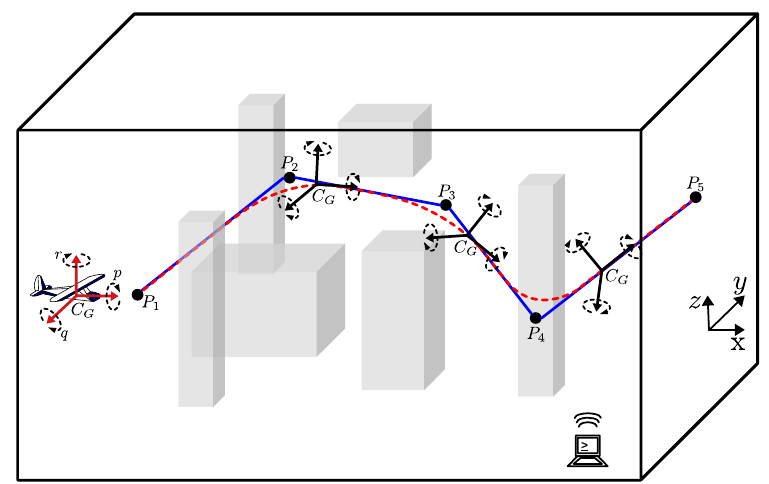
Figure 1. Perspective of the 3D flight problem for a fixed wing UAV, where C G represents the position vector of the center of gravity of the UAV. The global coordinate system CS g is placed at the origin, the orientation of the local body coordinate system CS b expressed by Euler roll, pitch and yaw angles respectively, which have been defined by three unitary orthogonal vectors aligned with the three axles of the vehicle and centered at C G . Finally, the angular velocities along the local axis of the UAV X , Y and Z are represented by p , q and r , respectively. The set of collision-free points P i is represented by black dots; the blue line describes the discrete path built from 3D path planning; the red dotted line is the new smooth optimized path that the UAV could